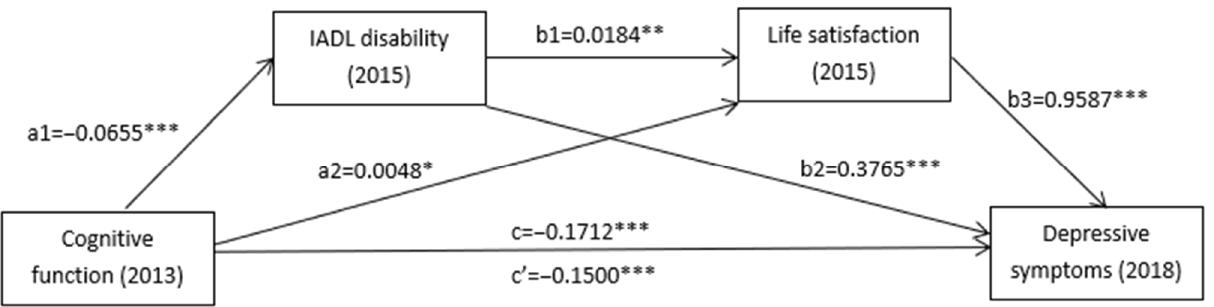
Figure 2. Serial mediation models for cognitive function, IADL disability, life satisfaction, and depressive symptoms. Note: Path coefficients were shown in the standardized regression coefficient.